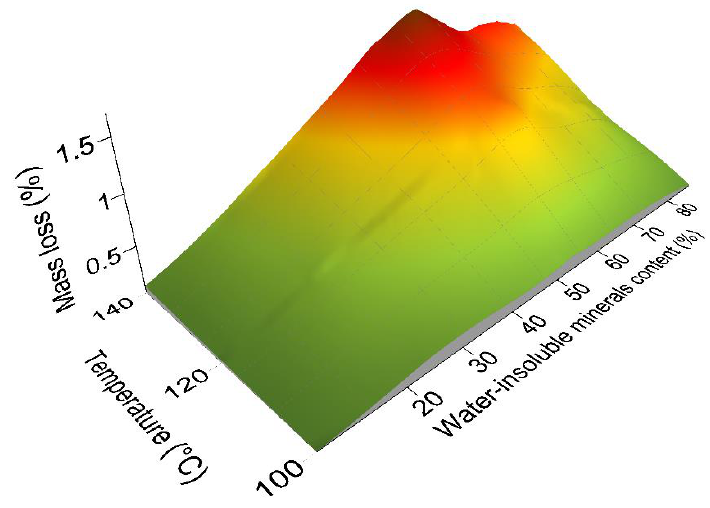
Figure 7. Mass loss of the Brown Zuber unit samples, depending on temperature and on the water-insoluble minerals content.